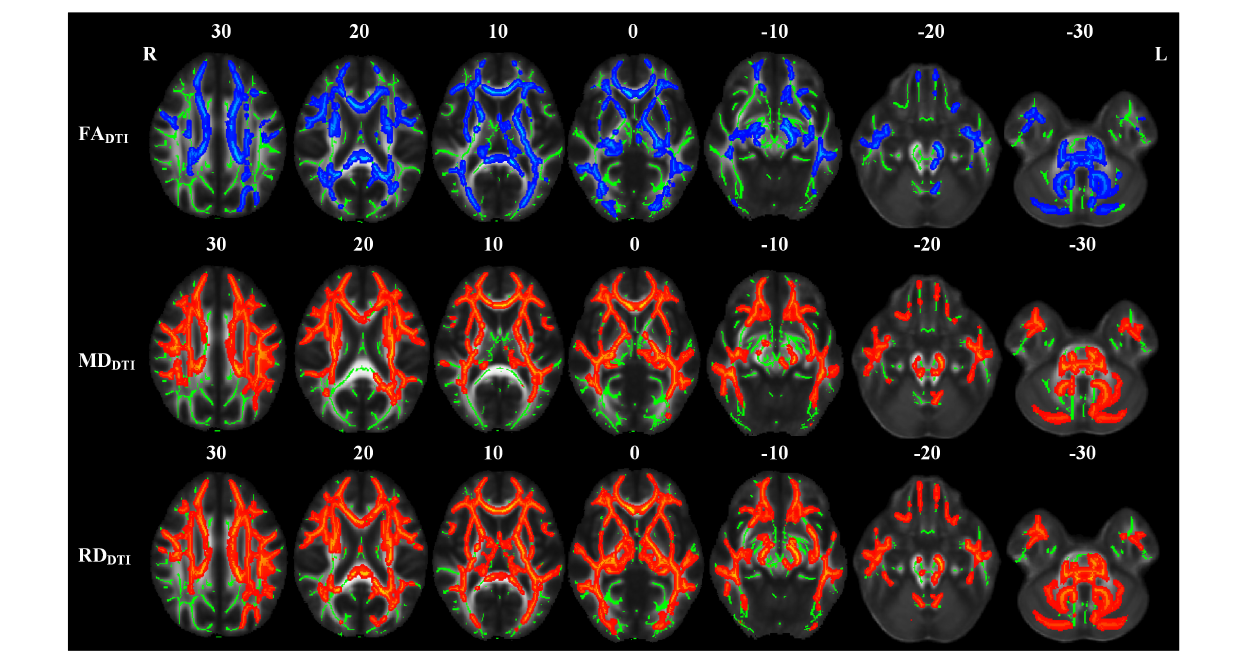
FIGURE 2 | TBSS analyses showed abnormal white matter tracts in the LPI group with DTI-derived parameters. Red indicated white matter tracts with significantly increased parameter values and blue indicated white matter tracts with significantly decreased parameter values. Green represented the mean FA skeleton of all subjects. L and R, left and right; FA, fractional anisotropy; MD, mean diffusivity; RD, radial diffusivity; TBSS, tract-based spatial statistics; DTI, diffusion tensor imaging.